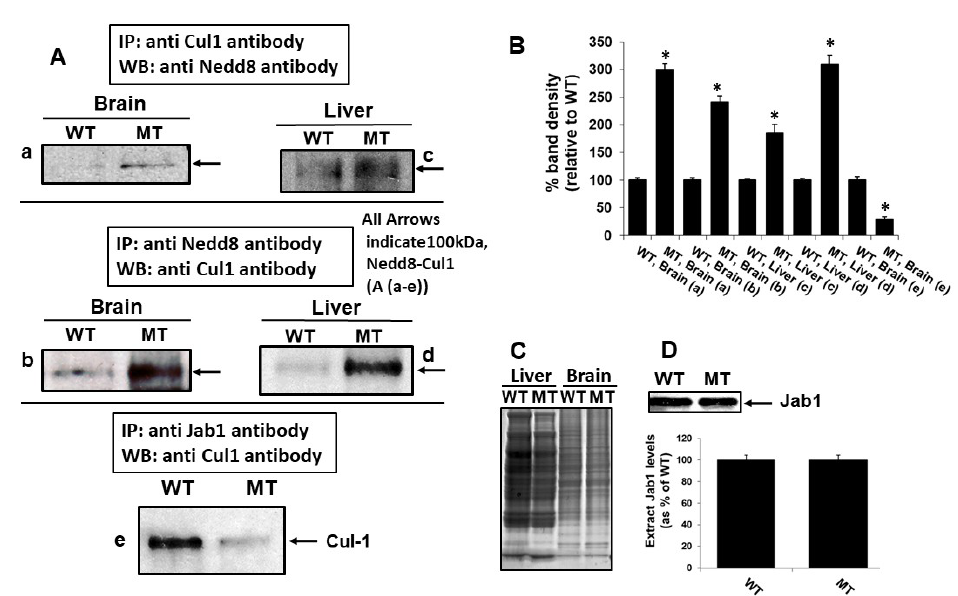
Figure 4. In vivo regulation of Jab1 activity by MsrA through monitoring Cul-1 neddylation levels in mouse brain and liver extracts. ( A ), a–d. Mouse extracts from 6 months old mice ( n = 3) were made in PBS and in the presence of protease inhibitors cocktail (Sigma-Aldrich). Immunoprecipitation (IP) experiments were performed on brain and liver extracts (500 µ g of protein per extract) using either anti-Cul-1 antibody or anti-Nedd8 antibody followed by Western blot (WB) analyses using anti-Nedd8 antibody or anti-Cul-1 antibody as the primary antibody, respectively. Ae. In a unique experiment, Jab1 was used as a “fishing” probe in an IP experiment using brain extracts, followed by Western blot analysis using anti-Cul-1antibody. Only the 100-kDa neddylated Cul-1 protein was identified due to the specific pull-down of the neddylated form of Cul-1 by Jab1. ( B ) Quantification of each band identified by Western blot analyses described in Panel ( A ) a–e, as determined by using the NIH Image-J program. All the observed di ff erences in the observed band levels between the WT and MT pairs were statistically significant as judged by student t -test analysis (* p < 0.01, n = 3 per strain). ( C ) Loading controls for the liver and brain protein levels, following Coomassie blue staining (to confirm the use of equal amount of proteins from each mouse strain per tissue in the IP experiments. WT, wild type; M, MsrA KO. ( D ) Western blot analysis of the mouse brain extracts using anti Jab1 antibody as the primary antibody and quantified by the NIH Image-J program. WT, wild type; MT, MsrA KO. Arrows shown in ( A ) a–e indicate the position of the neddylated 100-kDa Cul-1 (deneddylated form runs as ~90 kDa protein, not detected). The shown WB and Coomassie blue staining experiments are representatives of